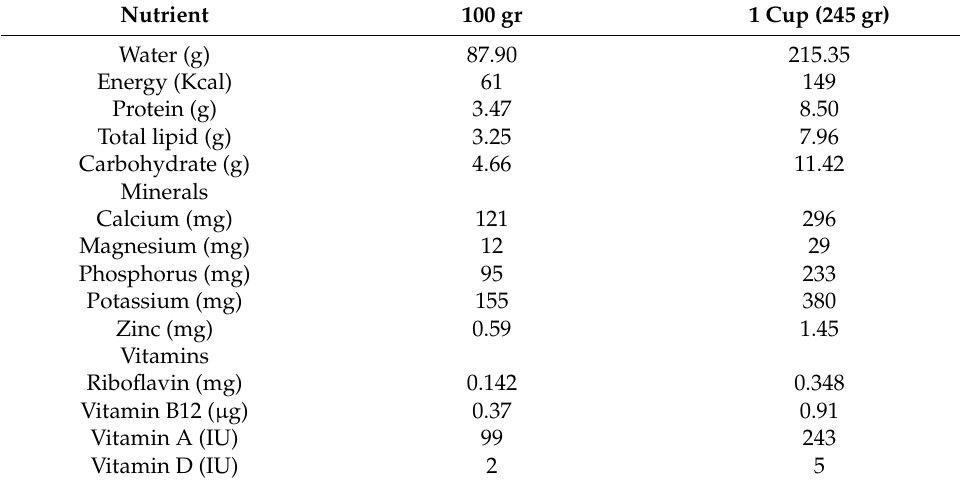
Table 1. Basic nutrient report, yoghurt, plain, and whole